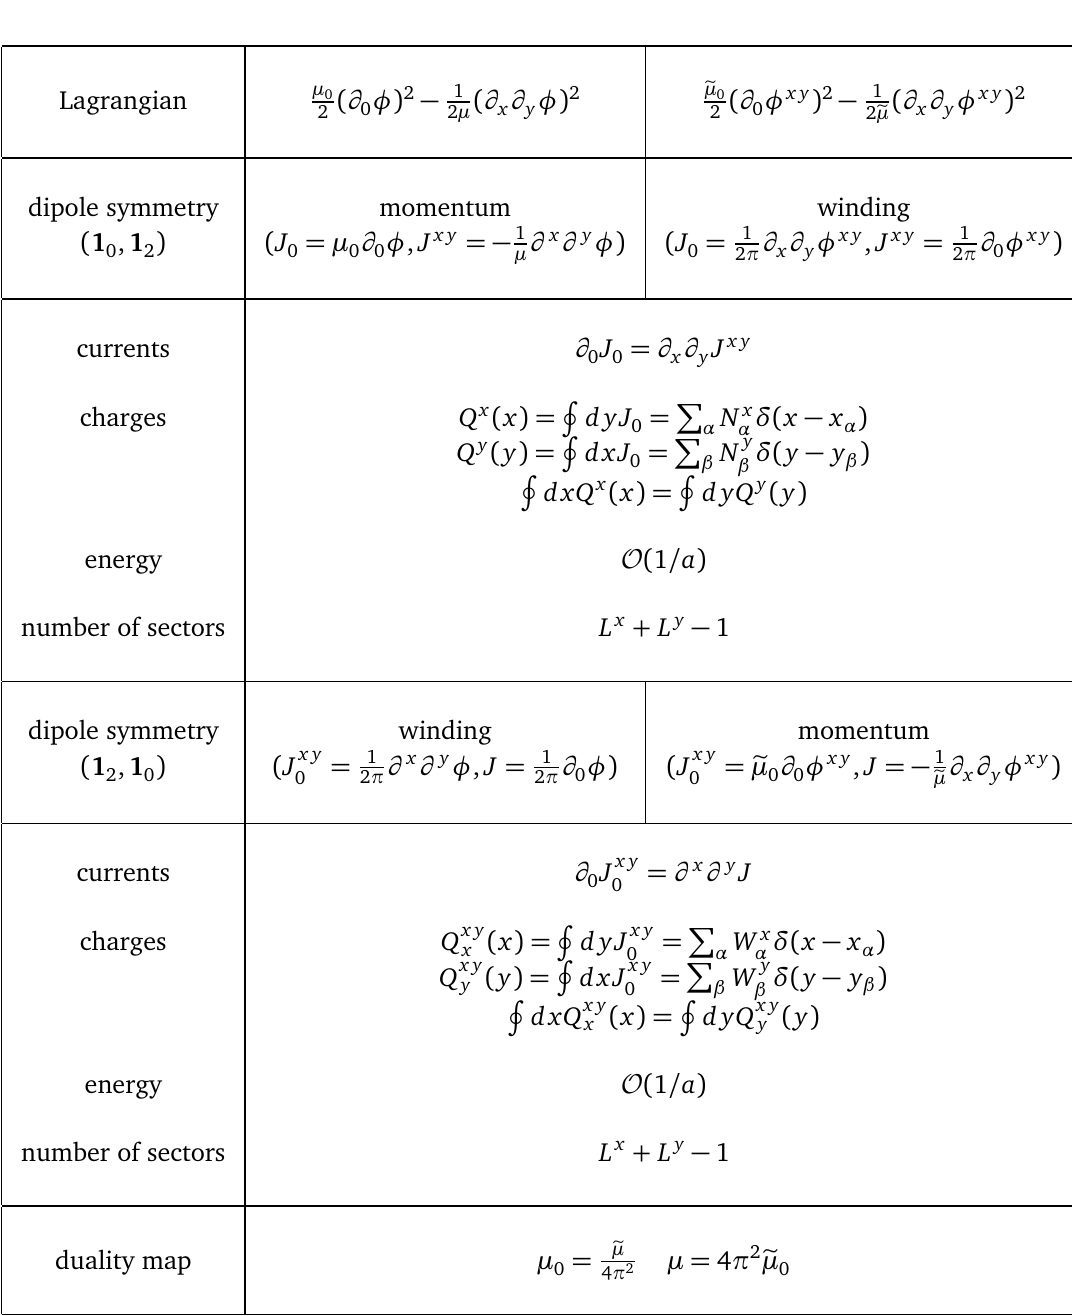
Table 1: Global symmetries and their charges in the 2 + 1-dimensional scalar theories φ and φ x y . The energies of states that are charged under these global symmetries are of order 1 / a